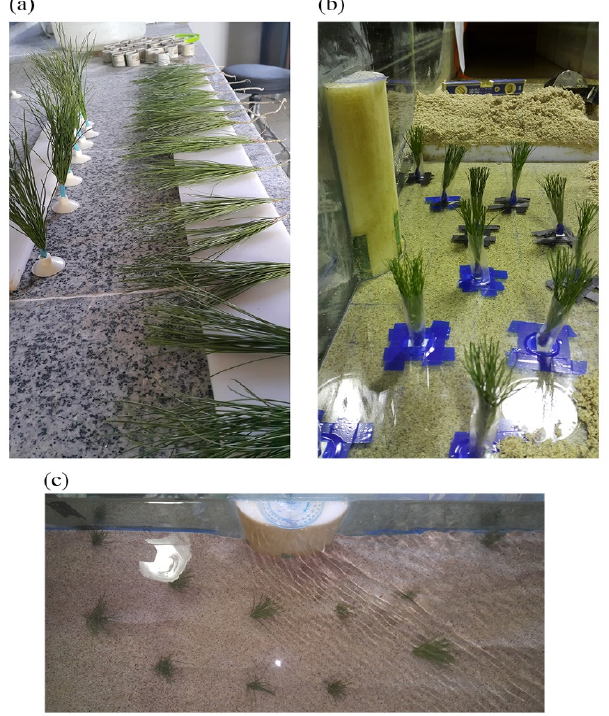
Figure 1. ( a ) Vegetation bunches consisting of pine needles used in experiments; ( b , c ) vegetation bunches installation and